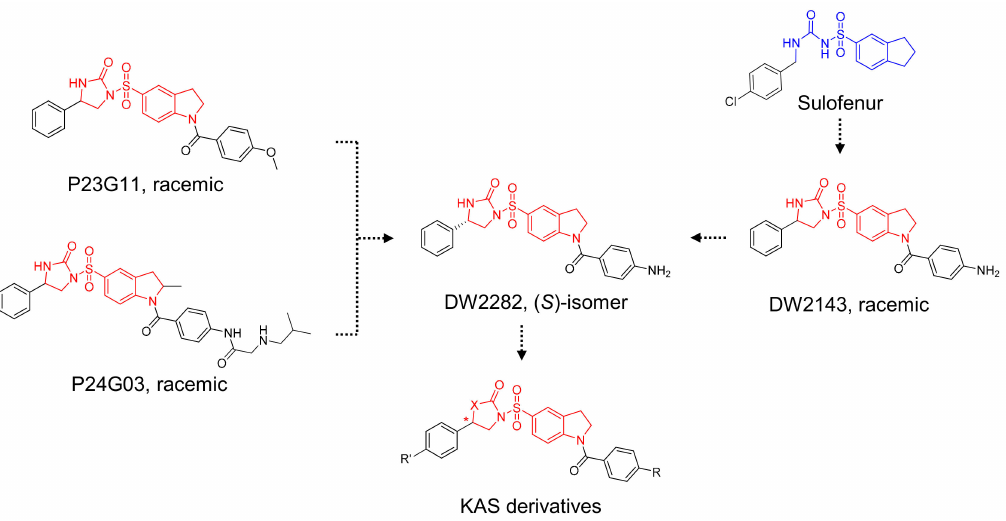
Figure 2. Schematic diagram of chemical structure for the design of KAS